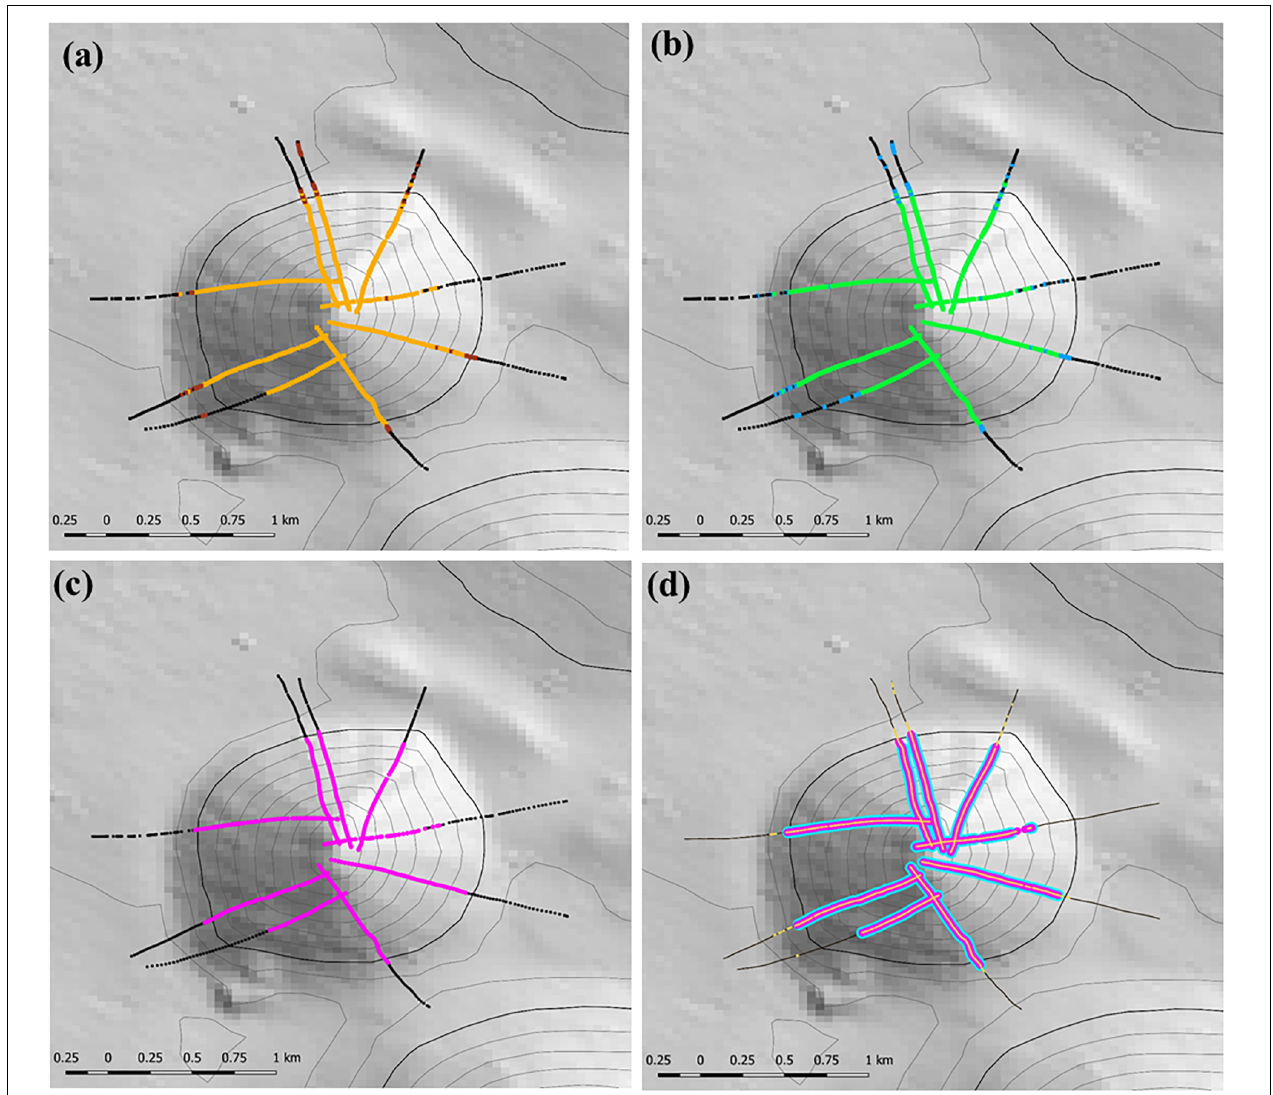
FIGURE 5 | Illustration of the initial steps used to identify the presence and location of VME habitats at study site 8 (Seamount Z16) where camera transects were conducted; heavy depth contour = 1350 m depth: (a) step 1 – locating the presence of the matrix-forming stony coral Solenosmillia variabilis in 12 m long segments – orange = live coral, brown = dead coral; (b) step 2 – applying criteria of percentage cover and presence of live coral heads to identify segments representing VME habitat status (base-case scenario of 15% cover of coral matrix and ≥ 1 live coral head) – black meets neither criteria, blue meets one criterion, green meets both criteria; (c) step 3 – mapping segments with VME habitat status into patches with VME habitat status (pink) using a classification that requires ≥ 3 segments in a five segment moving window (3:5 ratio) to have VME habitat status; and (d) step 4 – coral reef VME (blue) is identified and mapped along patches with VME habitat status by applying a (minimum) live coral head threshold calculated across all transects. Depth contours: 50 m intervals with 1350 line